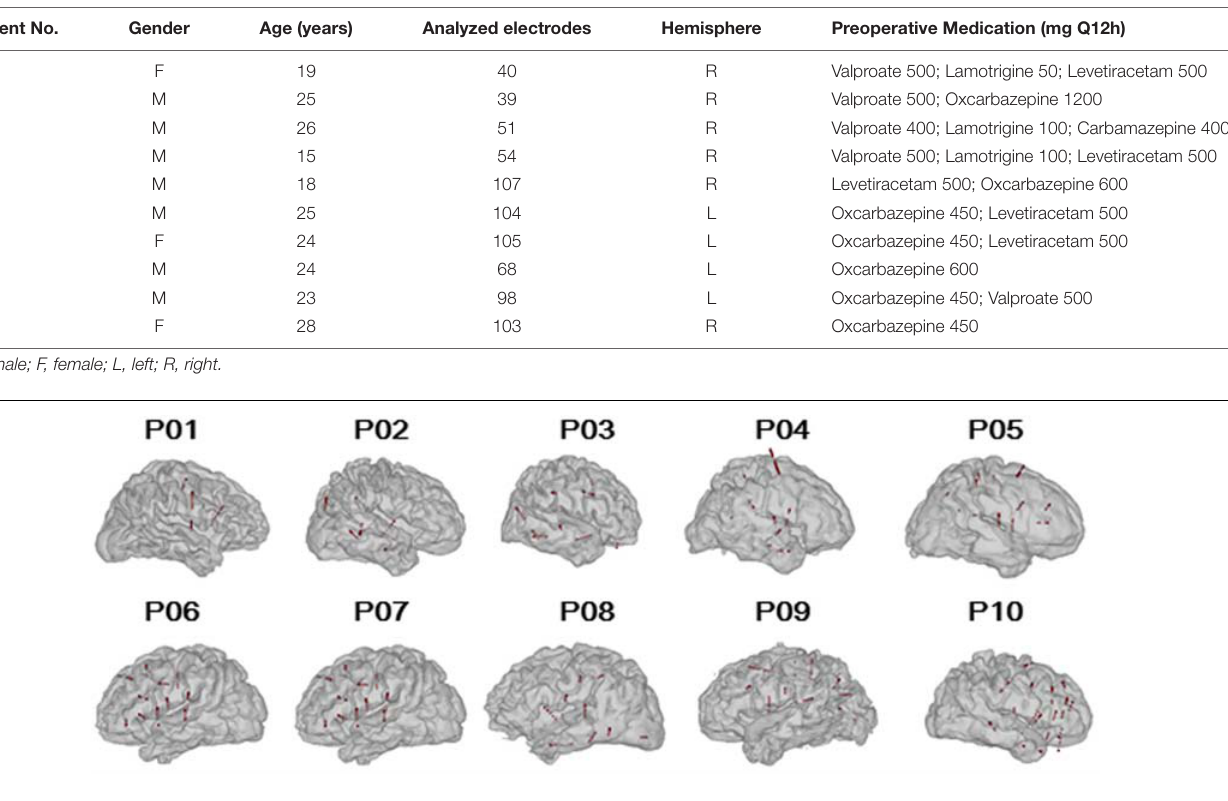
Testing System (AUDit and System 824, Larson Davis, Depew, NY, United